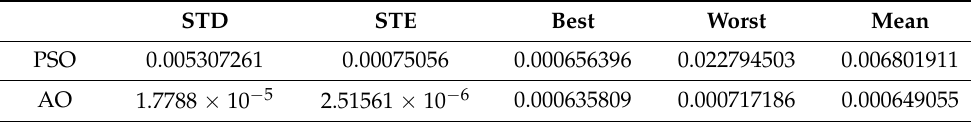
Figure 3. Weibull distributions: Shark El-Ouinate site. Table 5. Statistical results of convergence characteristics: Zafarana site.